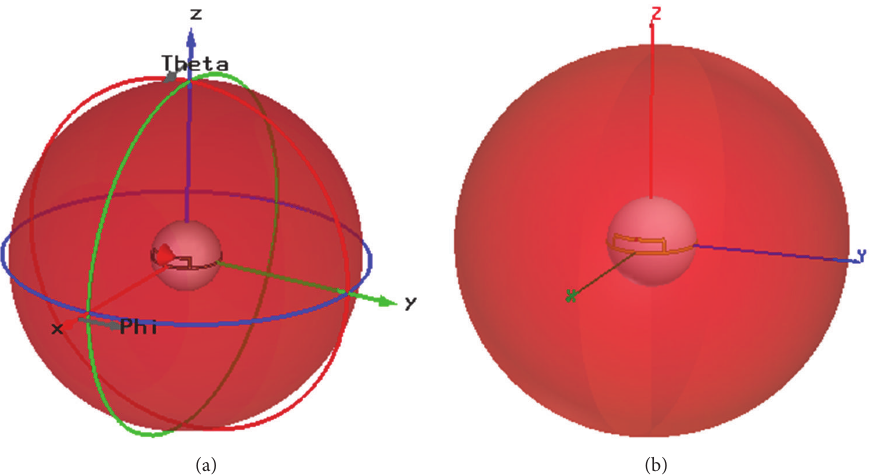
Figure 11: Radiation patterns ( 𝐸 total ) in 3D of the 3D spherical antenna (Table 4): (a) simulated by CST and (b) simulated by HFSS.